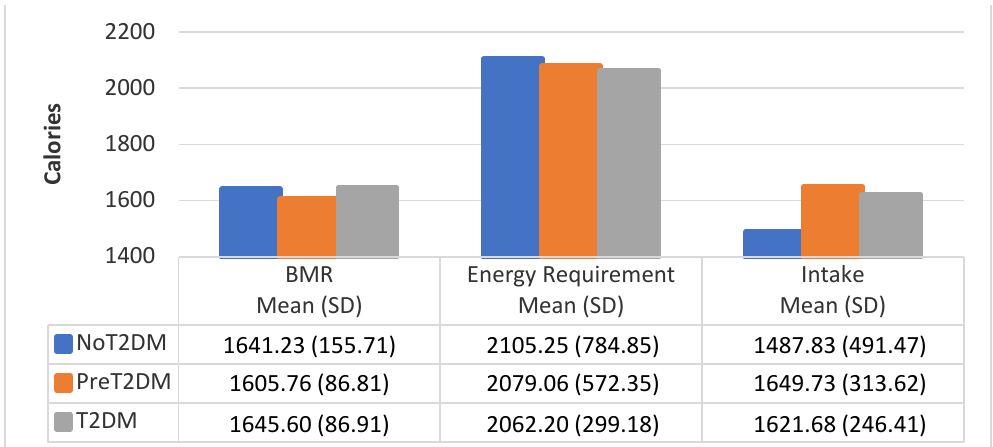
Figure 5. BMR, energy requirement, and caloric intake for male participants by diabetes status.